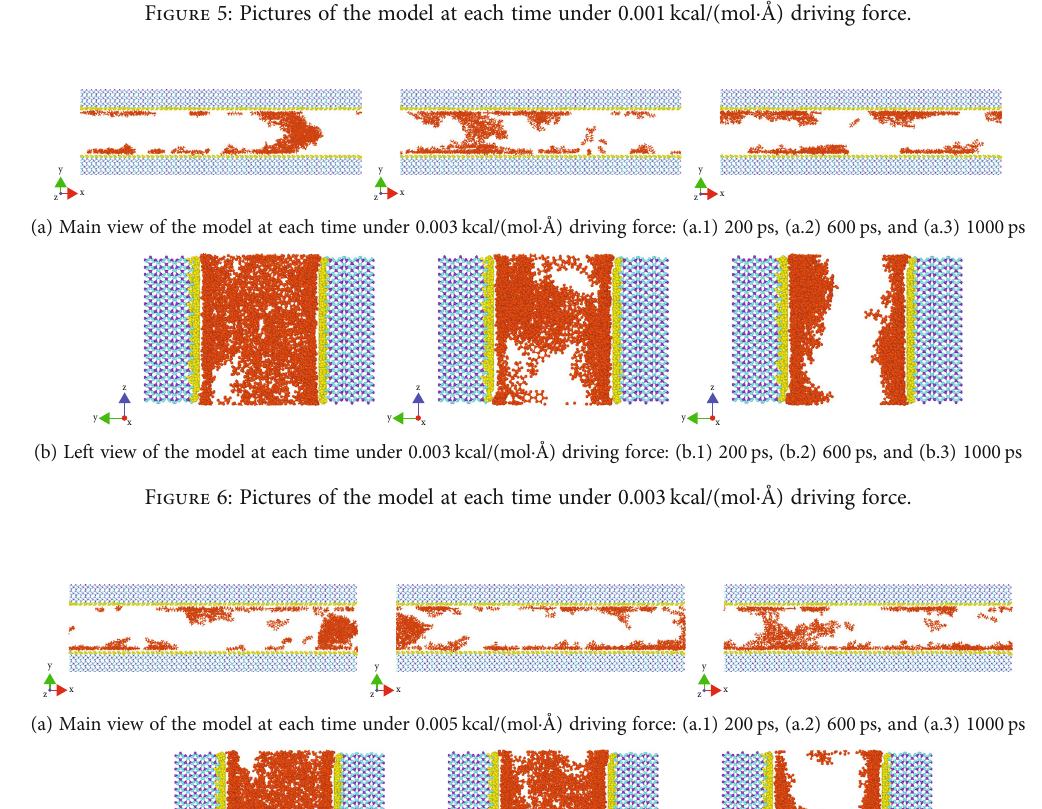
Figure 5: Pictures of the model at each time under 0.001 kcal/(mol · Å) driving force.